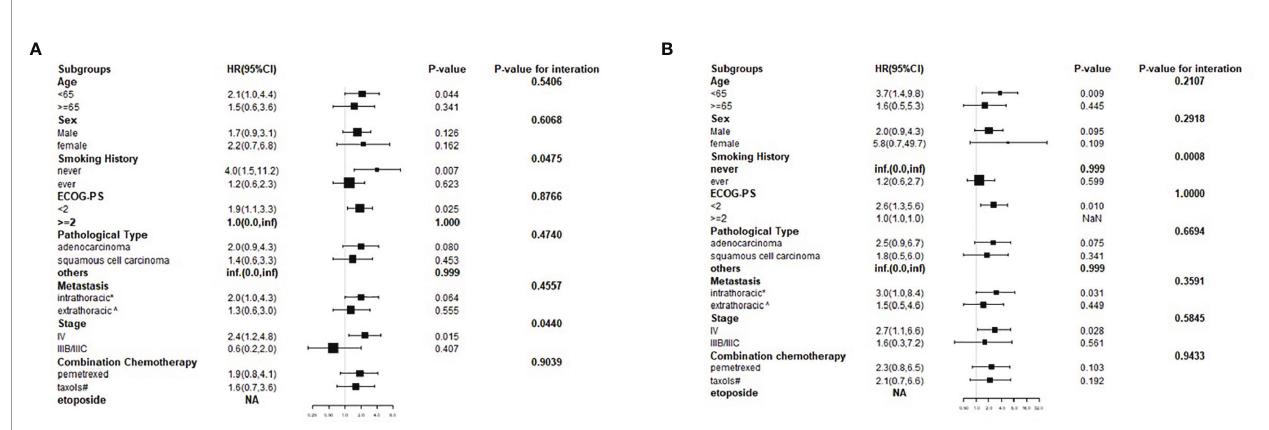
FIGURE 4 | Forest plot for presenting the hazard ratio of PFS (A) and OS (B) in high HSP90 a group in advanced lung cancer patients treated with PD-1/PD-L1 inhibitors plus chemotherapy.